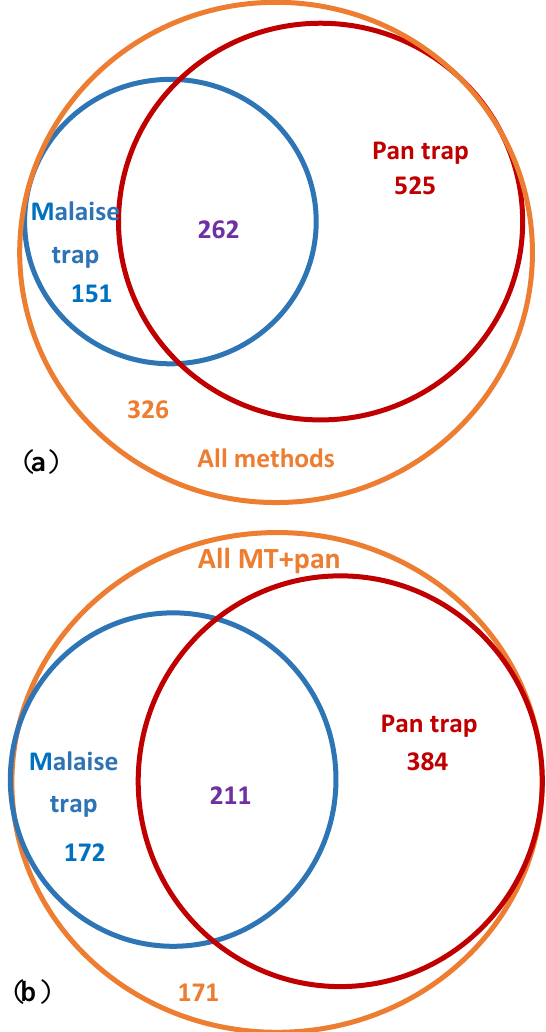
Figure 7. Comparative performance of Malaise traps and pan traps in the summer of 2018, corrected for phenology. ( a ) All Malaise trap samples compared against all pan trap samples and all other collecting methods. ( b ) Malaise and pan trap sampling from approximately similar date ranges compared against all BINs from Malaise and pan traps combined. Dates of Malaise trap sampling: Water